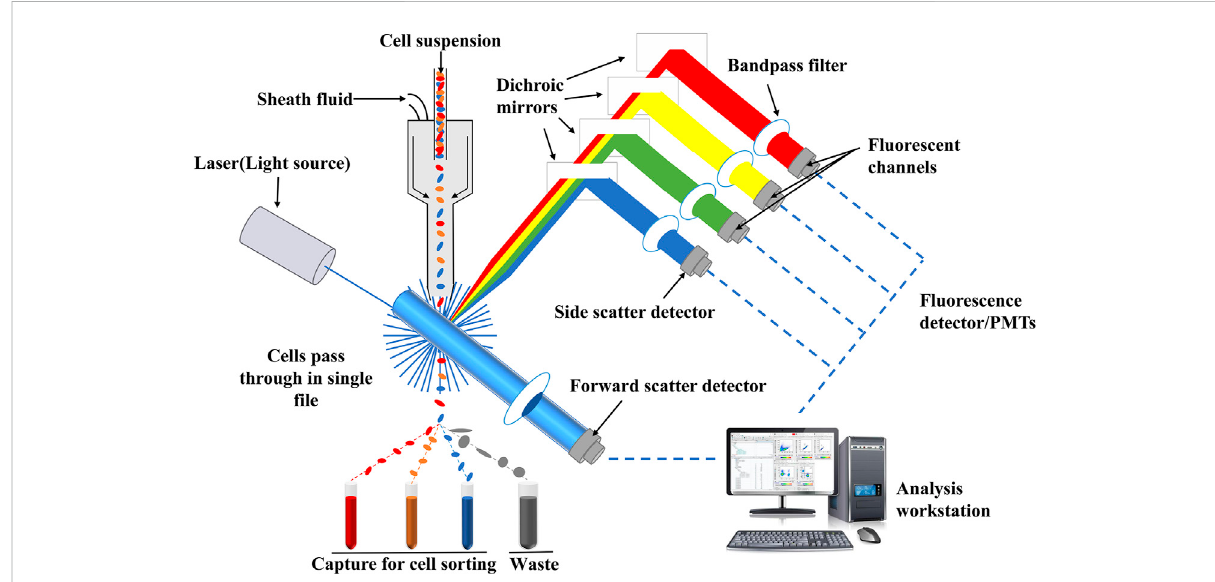
FIGURE 5 Schematic diagram of fl ow cytometry. Fluorescence signals which re fl ect the intensity of cell membrane surface antigen can be captured by fl uorescence detector, and then, ampli fi ed and converted into an electrical signal by a photomultiplitizer. The continuous electrical signal is converted into a digital signal which can be recognized by a computer and processed into an image for in-depth